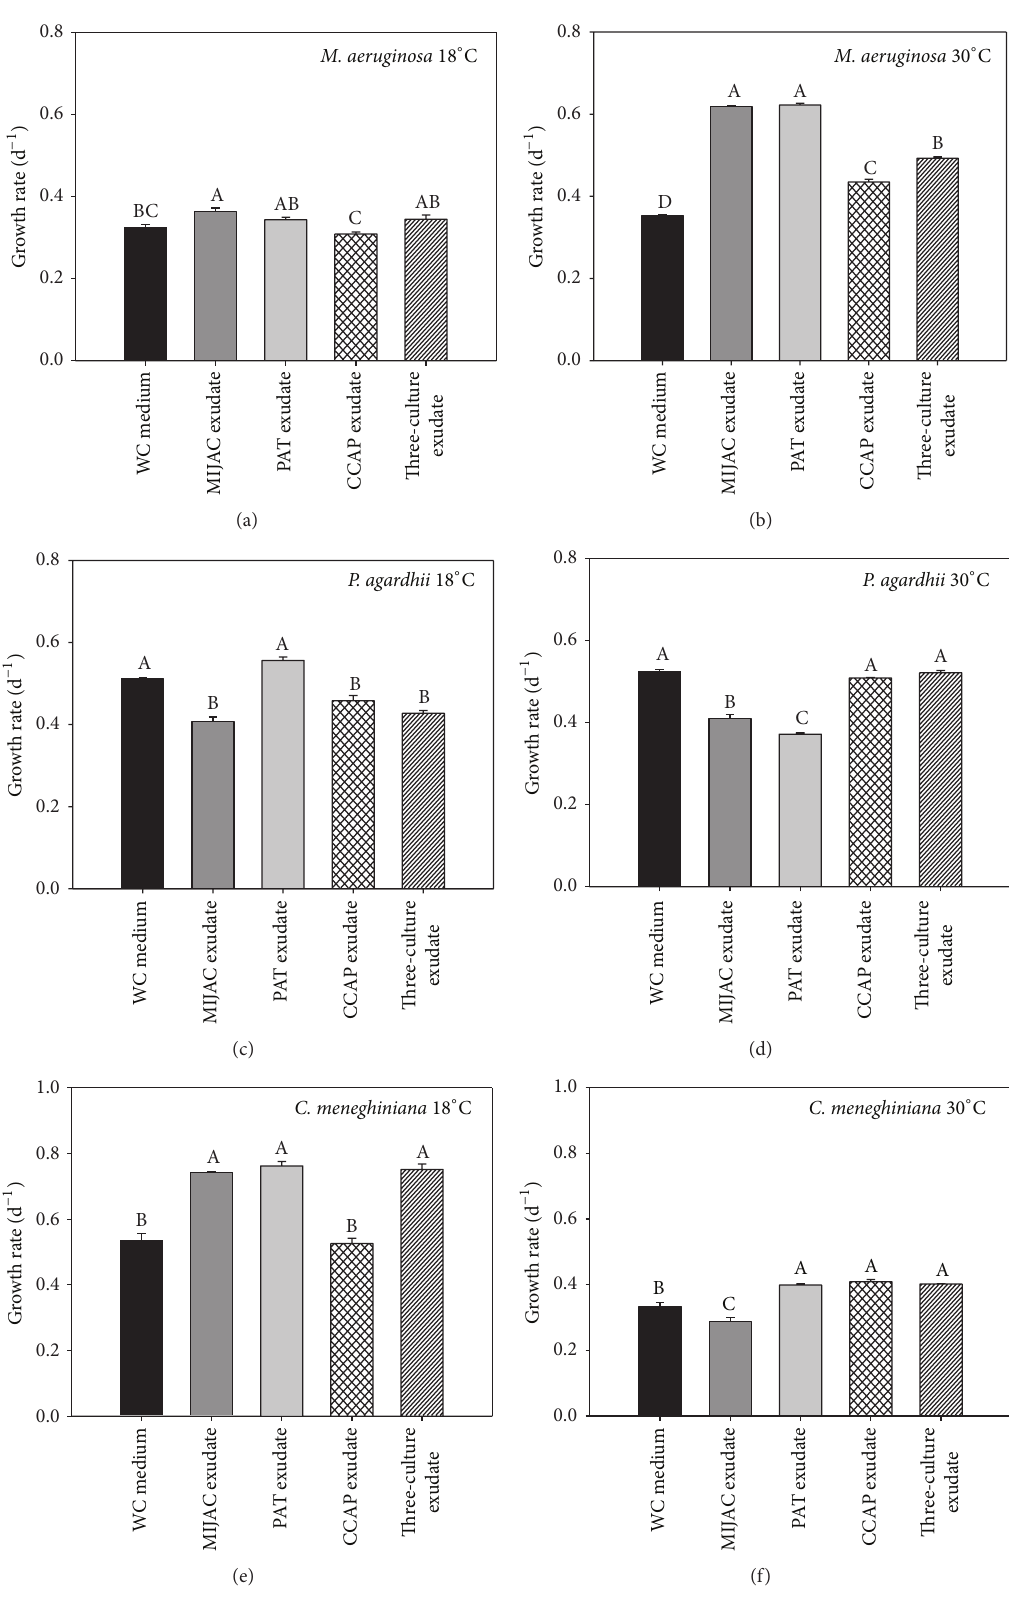
Figure 7: Chlorophyll- a -based growth rate of M. aeruginosa , P. agardhii, and C. meneghiniana cross-culture at two different temperatures (18 ∘ C and 30 ∘ C). Different letters represent significant differences at 𝑝 < 0.05